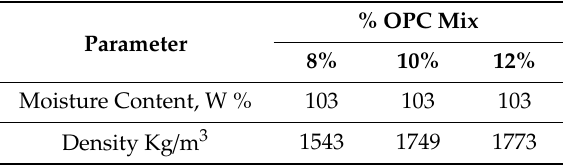
Table 5. Density and moisture content of OPC